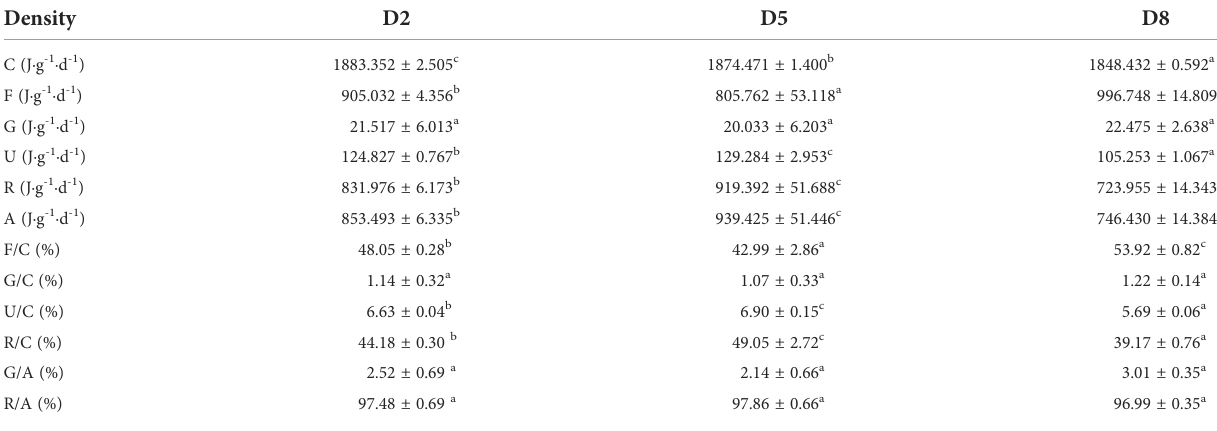
Data are mean ± S.D. and different letters in the same row represented signi fi cant differences at different stocking densities ( P <